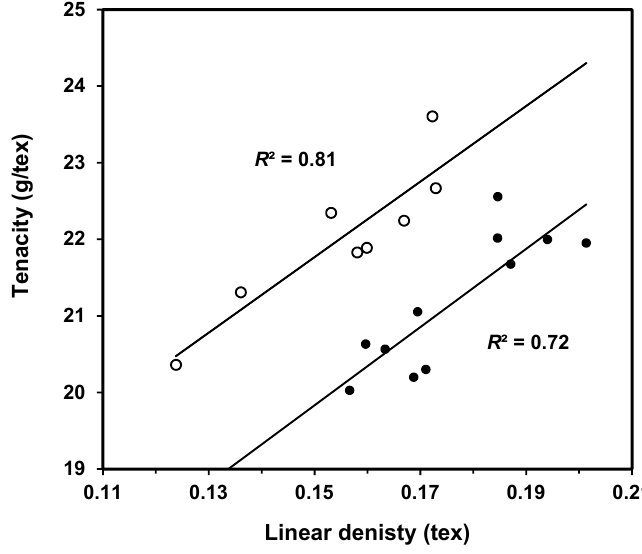
Figure 5. Representation of Figure 4 with two subsets of fine ( ○ ) and coarse ( ● ) fibers.